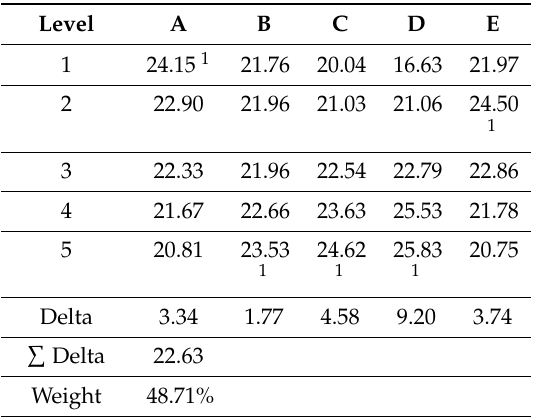
Table 8. Factorial e ff ects and weight factors for the exergy of air outlet recovery.